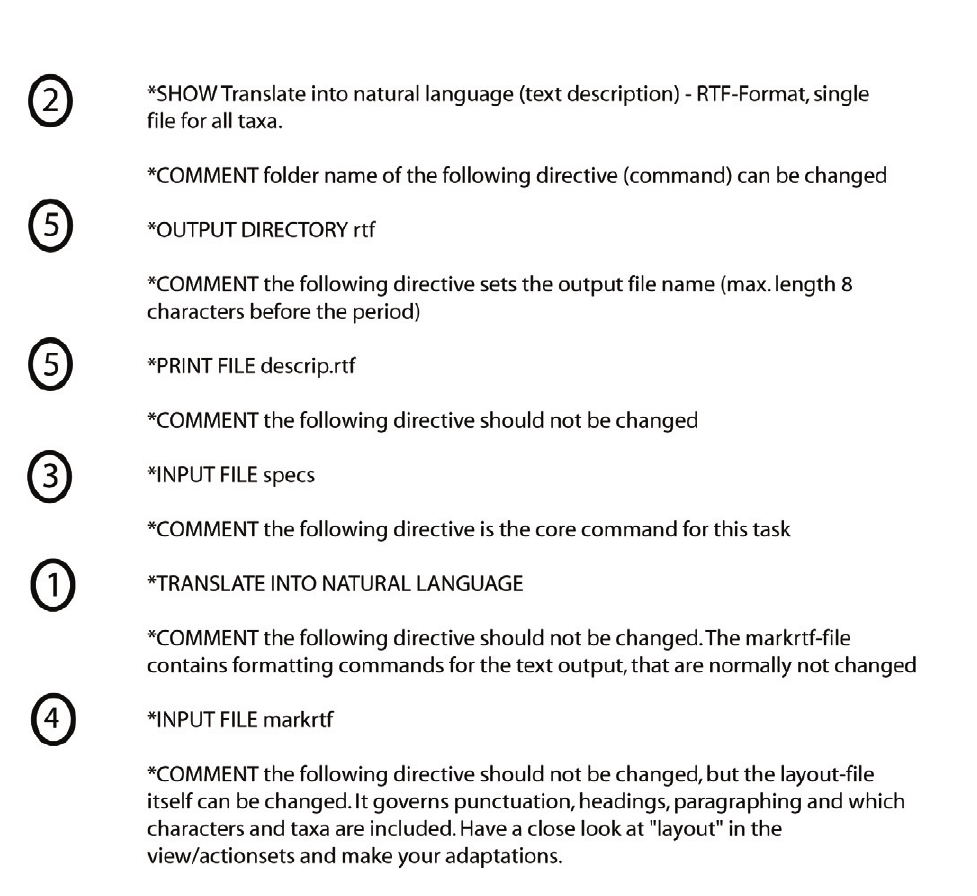
Figure 31. Th e tonatr directive fi le contains the commands for producing natural language descriptions. Th e numbers to the left of the directive fi le indicate diff erent classes of directives (see in Table 4). Th e grey ovals show commands where input of the user might be required. (continued on next